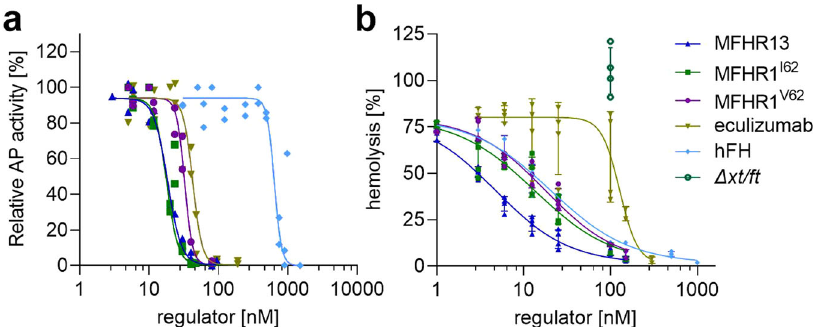
Fig. 8 MFHR13 regulates overall AP activation and protects host-like surfaces. a Regulation of AP activation. AP in normal human serum was activated in LPS coated wells. The inhibition achieved by addition of regulators was evaluated indirectly by quantifying C5b-9 complex formation by an ELISA-based method. AP activity was set to 100% for wells without regulators and wells with heat-inactivated serum were used as blank. Spontaneous activation was 42 ± 2.8%, measured in wells without LPS. Data represent mean values ± SD from 4 independent measurements. MFHR13 regulatory activity was signi fi cantly better than hFH ( P < 0.0001, F(DFn, DFd) = 268.5 (1, 34)), and eculizumab ( P < 0.0001, F(DFn, DFd) = 83.38 (1, 25)). b Increasing concentrations of MFHR13 protected sheep erythrocytes from human complement attack in FH-depleted serum signi fi cantly better than MFHR1 I62 ( P = 0.0003, F(DFn, Dfd) = 16.02 (1, 36)), MFHR1 V62 ( P < 0.0001, F(DFn, Dfd) = 54.99 (1, 42)), hFH ( P = 0.0001, F(DFn, DFd)) = 18.73 (1, 31)), and eculizumab ( P < 0.0001 F(DFn, DFd)) = 111.7 (1, 33)). Hemolysis was set to 100% for wells without complement regulators and the negative control without FH-depleted serum was used as blank. Data represent mean values ± SD from 4 independent measurements. Δ xt/ft is a puri fi ed extract from the parental moss line used as negative control. DF degrees of freedom. Table 1 Overall AP regulatory activity evaluated by hemolysis and an ELISA-based method: Best fi t IC 50 calculated by 4PL nonlinear regression model.